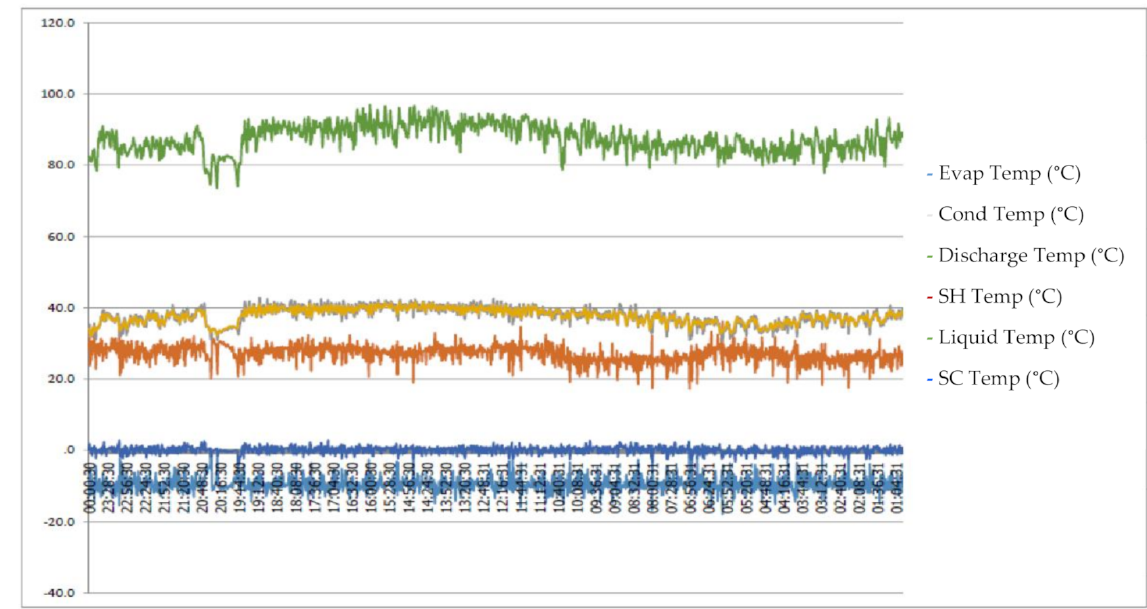
Figure 11. Temperature result for the digital-speed semi-hermetic